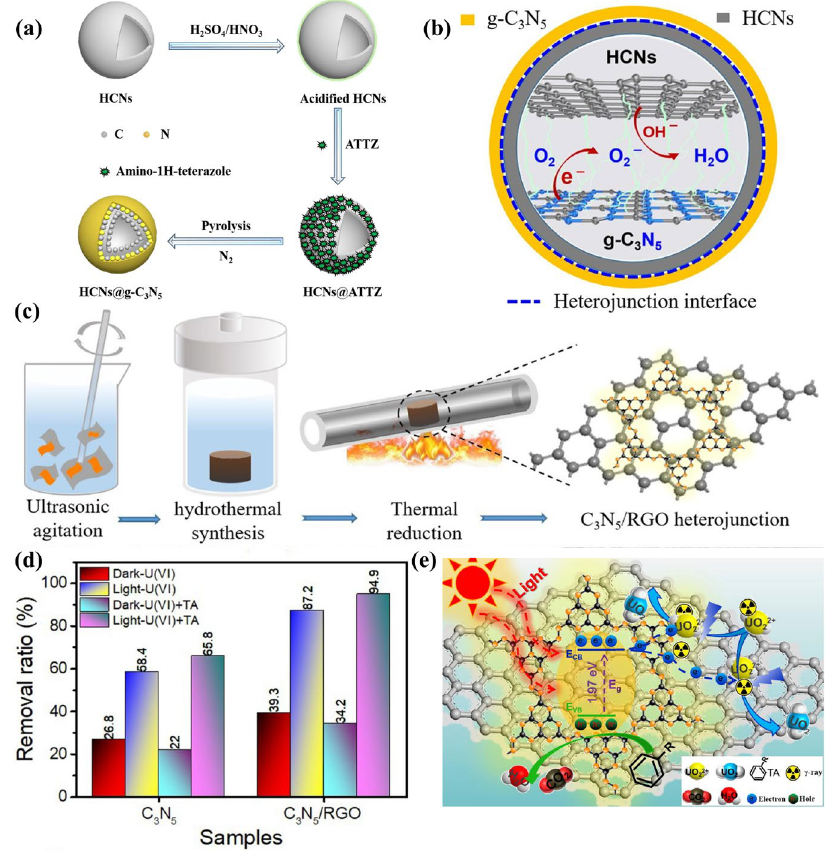
Figure 15. ( a ) Schematic illustration of HCNs@g-C 3 N 5 synthesis; ( b ) The core-shell structure and proposed charge transfer pathway in HCNs@g-C 3 N 5 ; ( c ) Schematic illustration of C 3 N 5 /RGO preparation; ( d ) The U(VI) removal ratio by C 3 N 5 /RGO under different conditions; ( e ) Mechanism schematic of U(VI) extraction by 3D C 3 N 5 /RGO. ( a − b )Adapted with permission from [61]. Copyright Elsevier B.V., 2021. ( c − e ) Adapted with permission from [62]. Copyright Elsevier B.V., 2021.